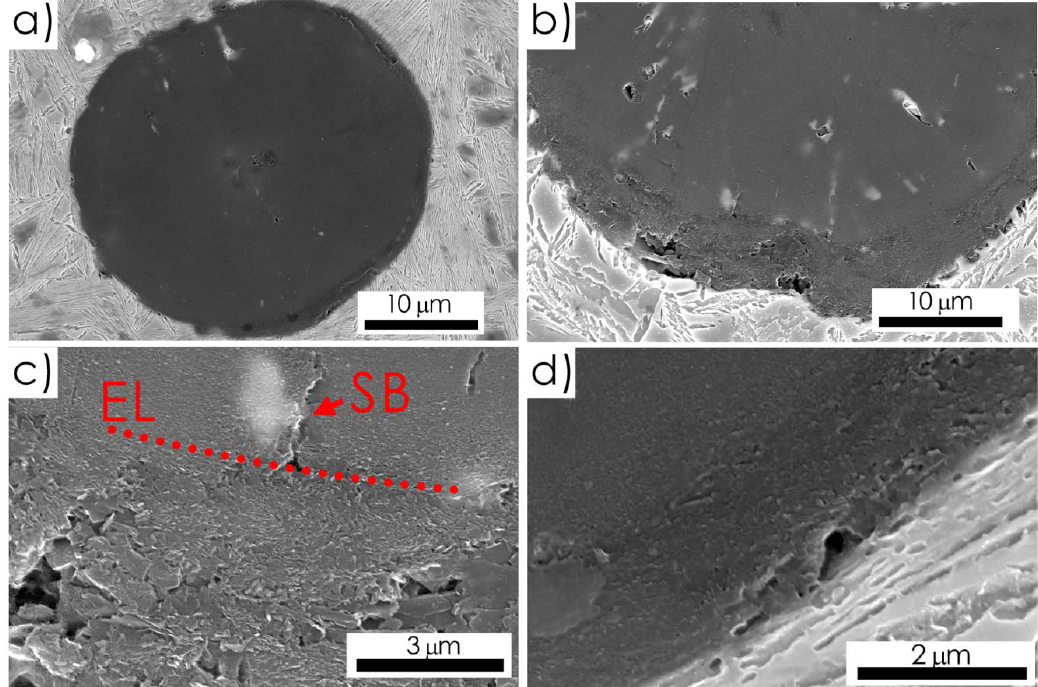
Figure 14. Graphite spheroid at a distance of 3 mm from the fracture surface in the ADI310 specimen, SEM: ( a ) The G ‐ M interface morphology, ( b – c ) shifted basal graphite plates in the external rim (SB: Sector boundary; EL: External layer), ( d ) an initial stage of the local G ‐ M debonding in pole area at the G ‐ M interface.